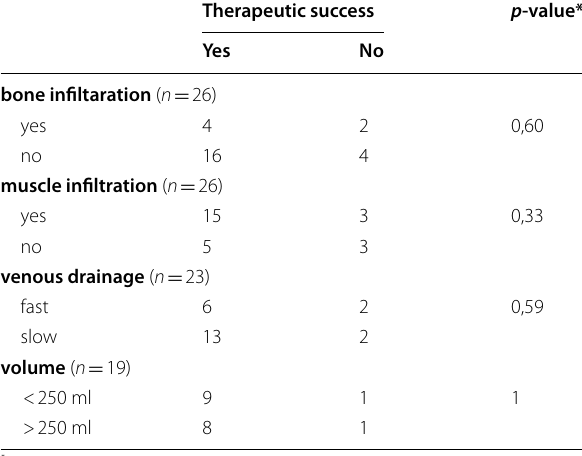
Table 9 Potential indicators for therapeutic outcome